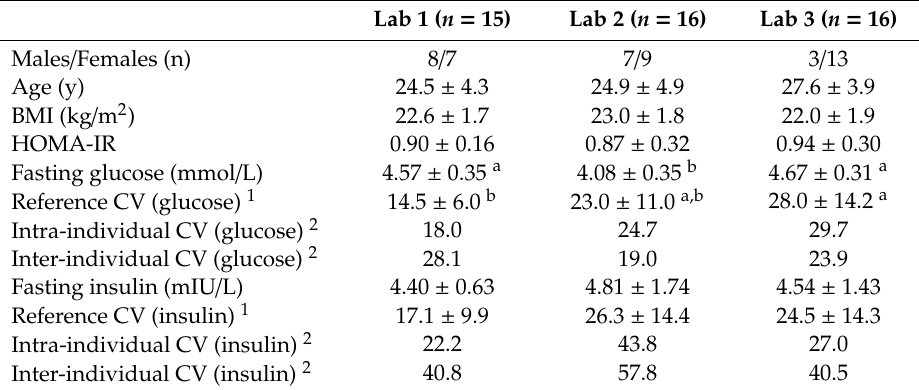
Table 2. Baseline characteristics (means ± SD) of participants at each